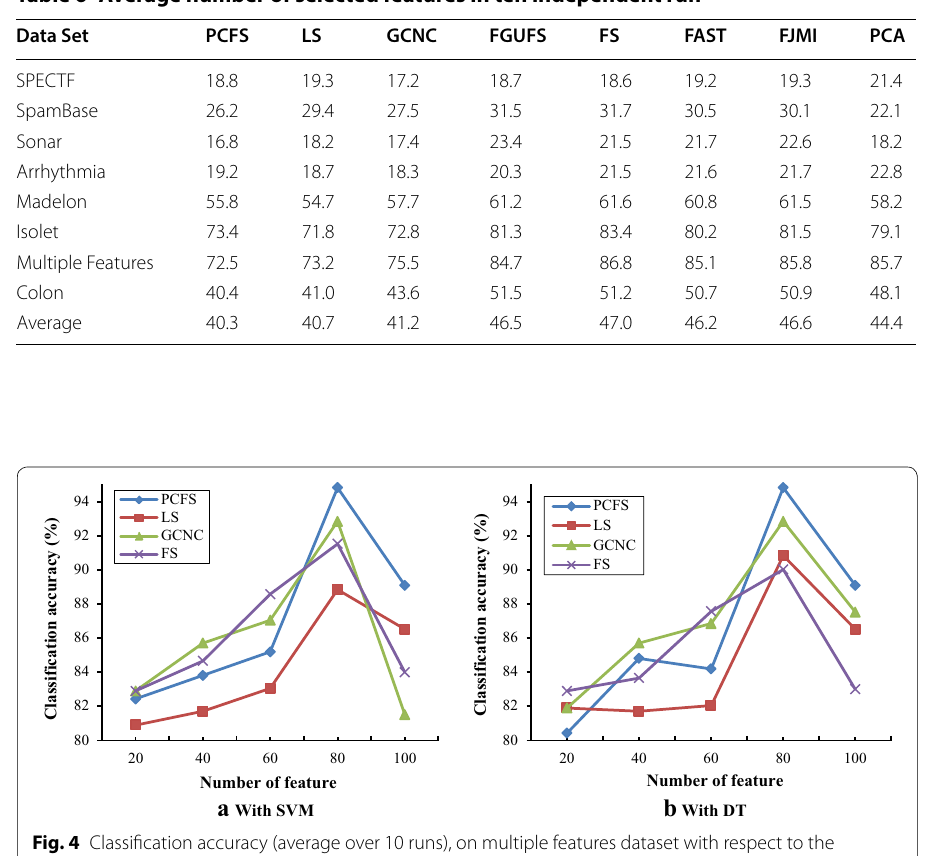
Table 5 Number of times different methods achieve the best results with DT classifier Dataset LS GCNC FGUFS FS FAST SPECTF SpamBase Arrhythmia Madelon Multiple Features 0 Colon Average